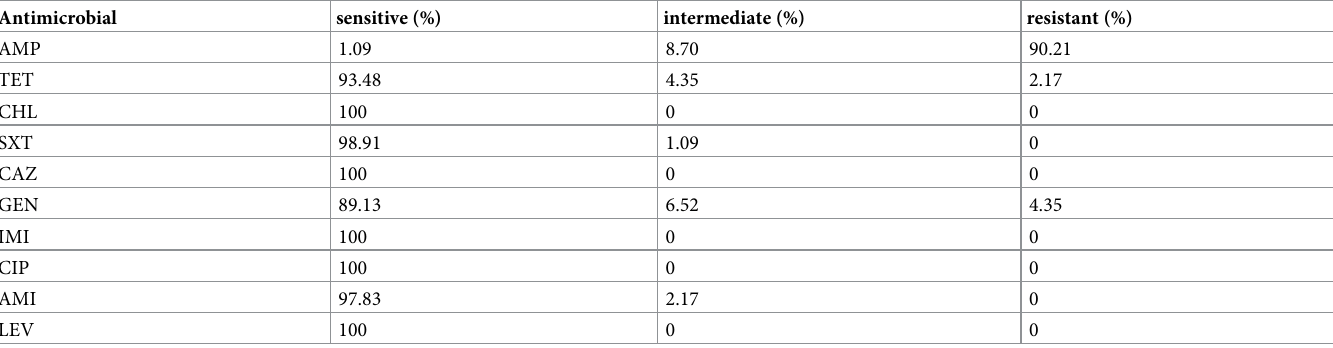
Table 3. Antimicrobial susceptibilities of the 92 V . parahaemolyticus isolates.